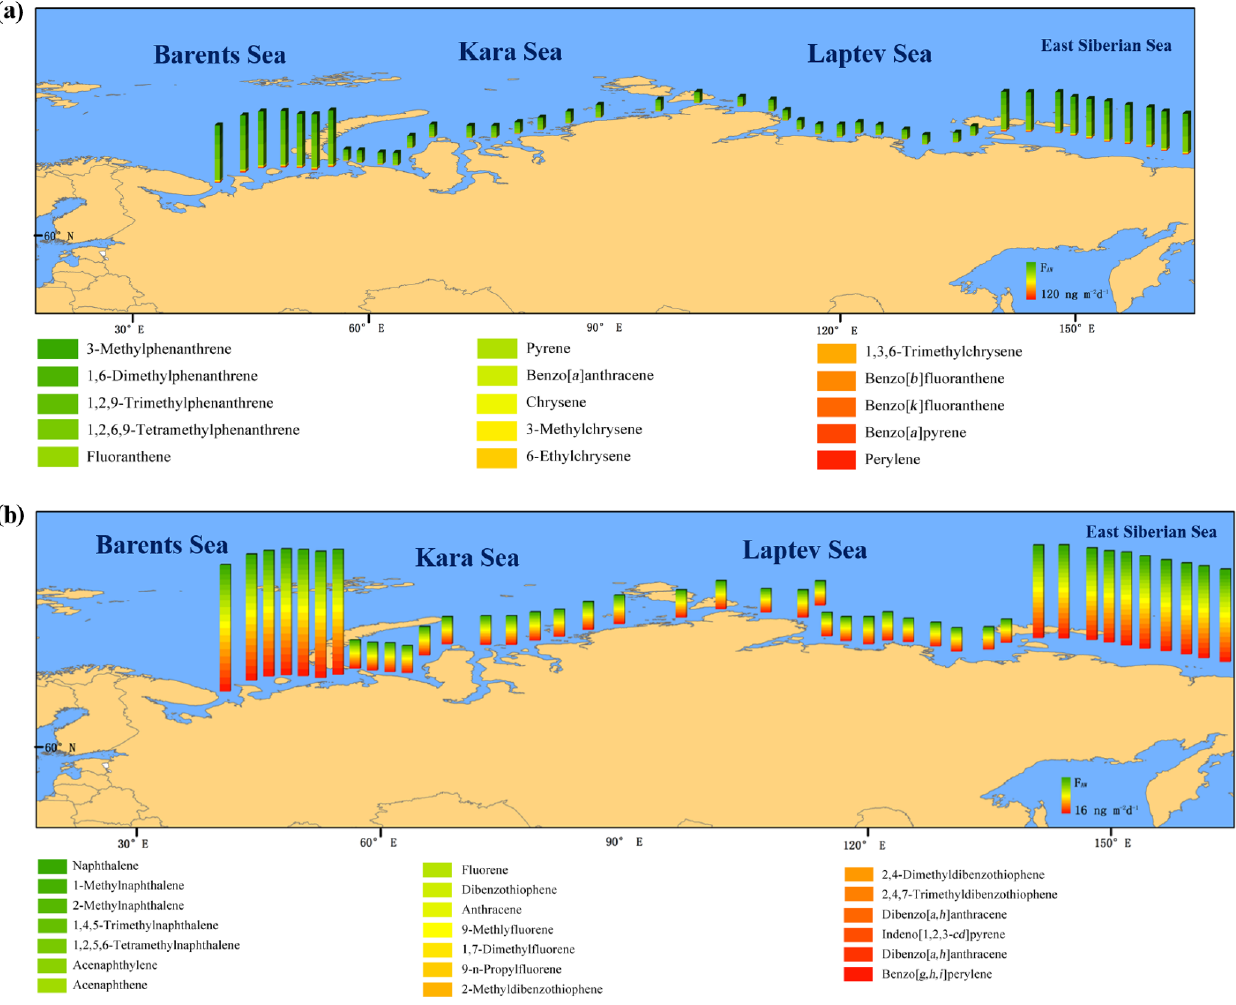
Figure 7. Measured atmosphere–ocean exchange of PAHs. (a) Net diffusive air–water exchange fluxes (all net deposition into the ocean) and (b) volatilization air–water exchange fluxes. Color bars indicate the sum of the 35 quantified compounds, and each color represents the individual PAHs in the bottom legend (colors range from red for the heaviest molecular weight PAHs to green for the lightest molecular weight